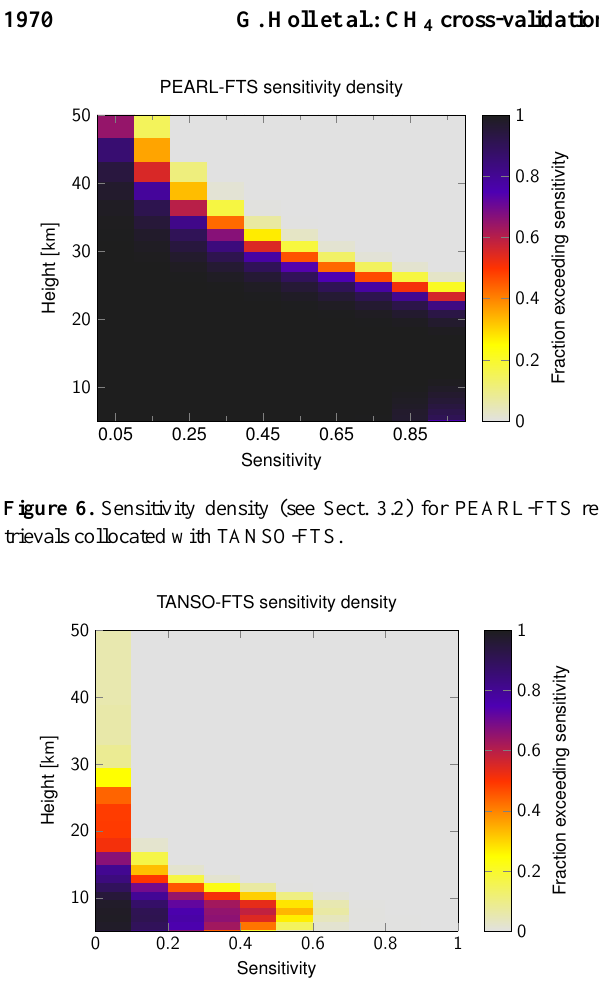
Figure 7. Sensitivity density (see Sect. 3.2) for TANSO-FTS re- trievals collocated with PEARL-FTS.